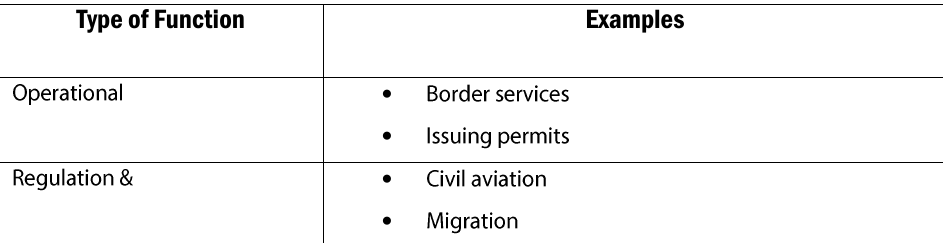
Table 1: Administrative Functions Suitable for the International Regional